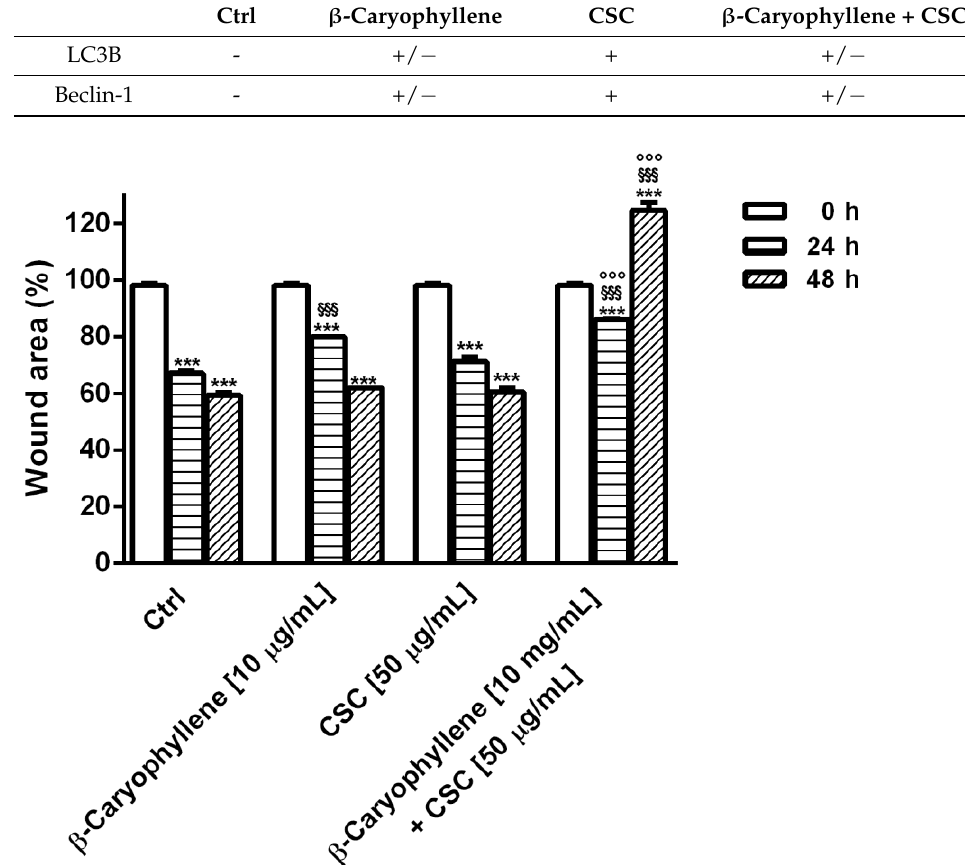
Figure 15. Quantification of MDA-MB-468 cells migration rate at 0 h, 4 h and 72 h ( n = 3) after treat- ment with β -caryophyllene and cigarette smoke condensate (CSC). Data are displayed as mean ± SE of at least three independent experiments with at least three technical replicates ( n = 9). *** p < 0.001, significant difference of each time point with respect to zero time (ANOVA + Dunnett’s multiple comparison post-hoc test). §§§ p < 0.001, significant difference with respect to the control at the same time point (Student’s t -test). ◦◦◦ p < 0.001, significant difference respect to CSC at the same time point (Student’s t -test).